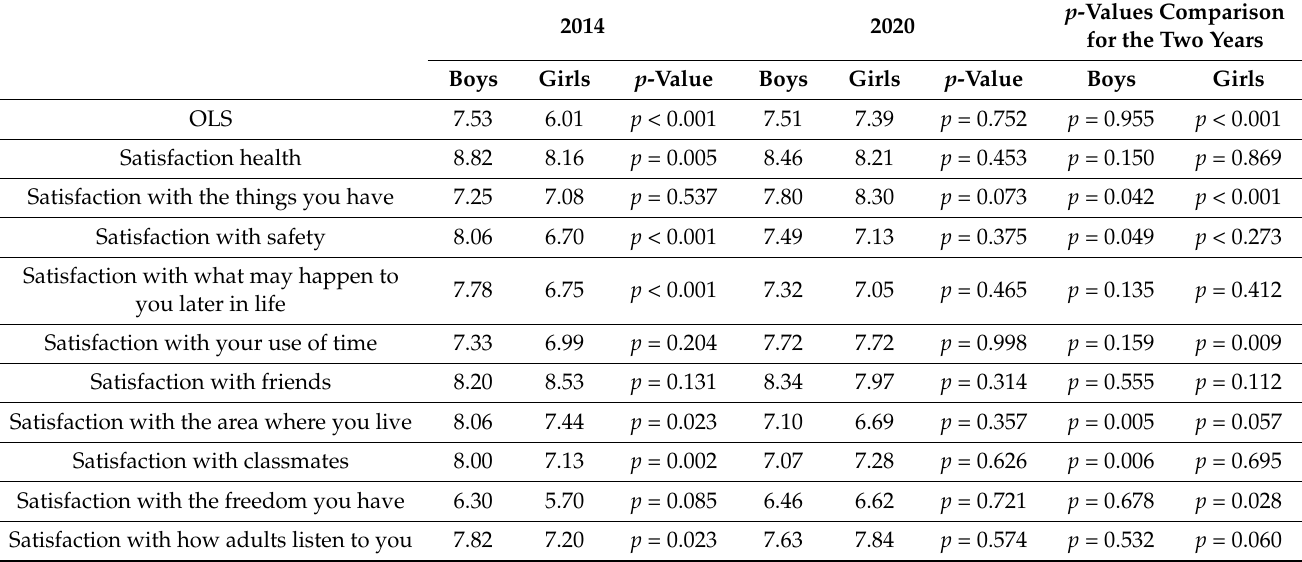
Table 3. Comparison of means of the comparable satisfaction items between both samples by gender and year of data collection .